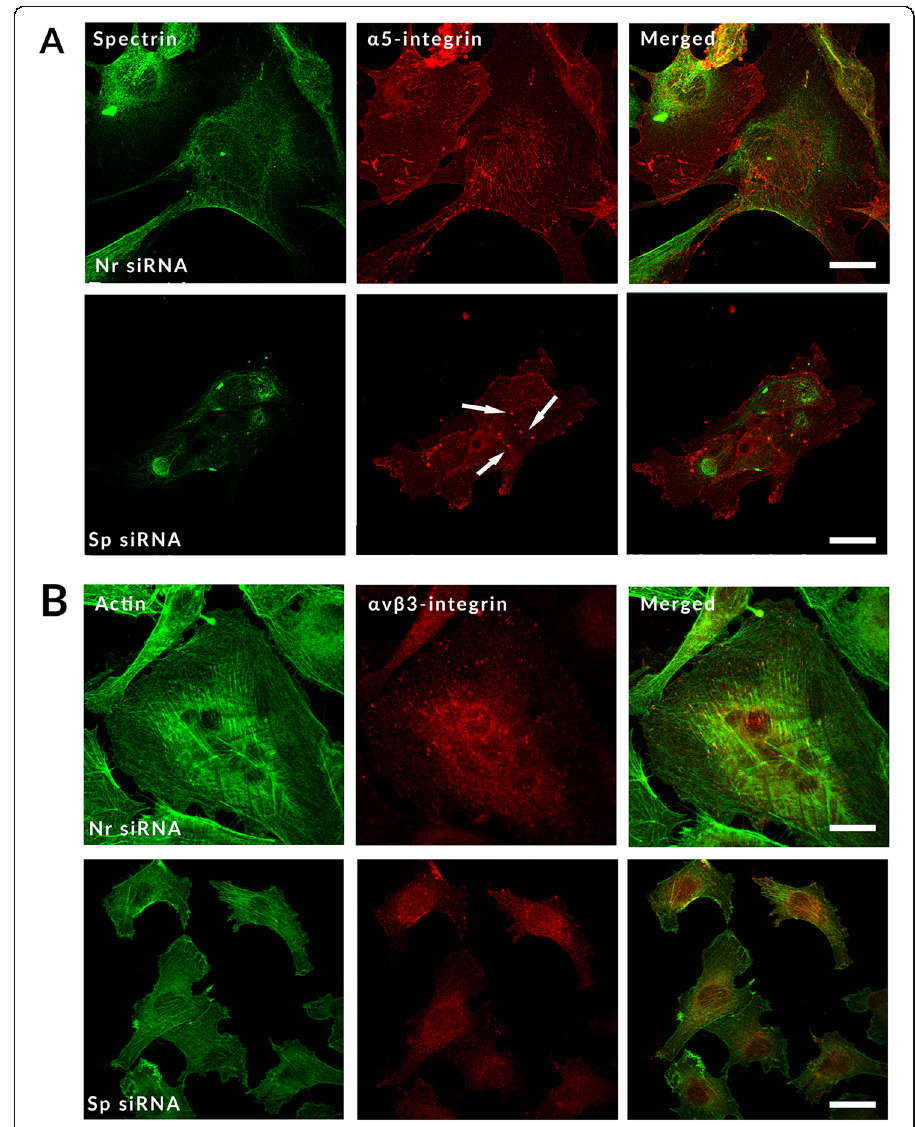
cells were labelled 72 h after transfection with either Nr siRNA or Sp siRNA with polyclonal antibodies (red) directed against α 5-integrin ( a ) and α V β 3-integrin ( b ). Spectrin and actin were labelled green. In Sp siRNA- treated cells, α 5-integrin distribution is modified (present as aggregates) and α V β 3-integrin does not accumulate in focal points and forms aggregates in the cytoplasm. Depletion of spectrin is also associated with decreased expression of these integrins. Scale bar = 20 μ